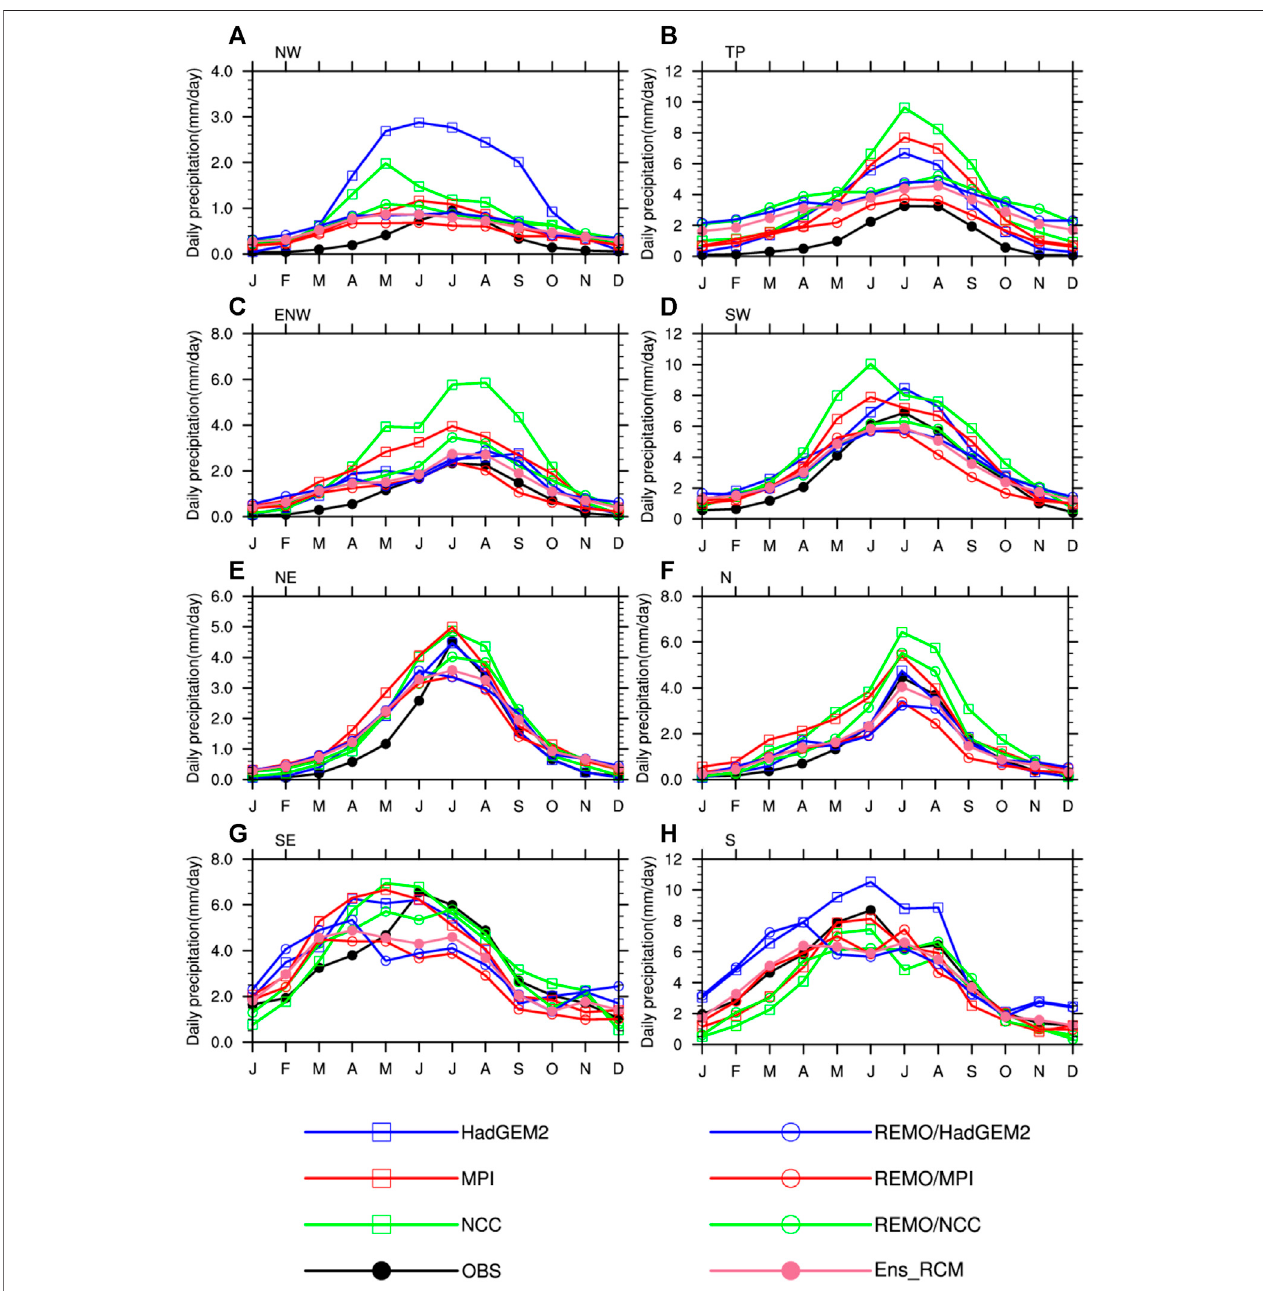
FIGURE 3 | Monthly cycle of precipitation in the eight sub-regions from the simulations and the observations.